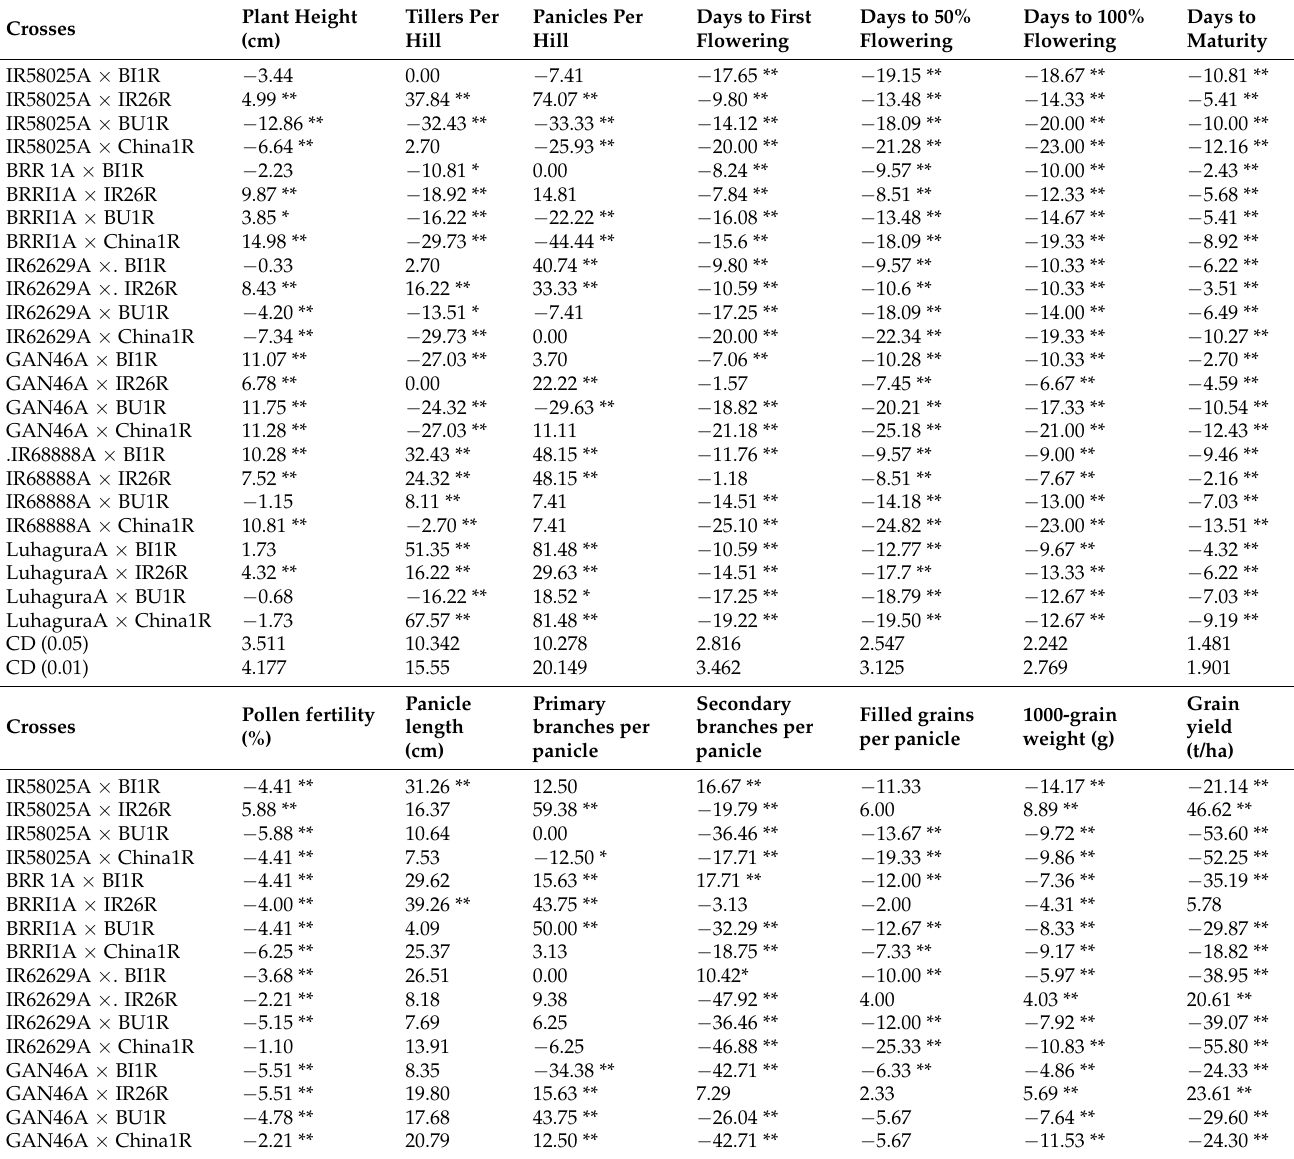
Table 7. Estimates of standard heterosis of 24 crosses for yield and its contributing